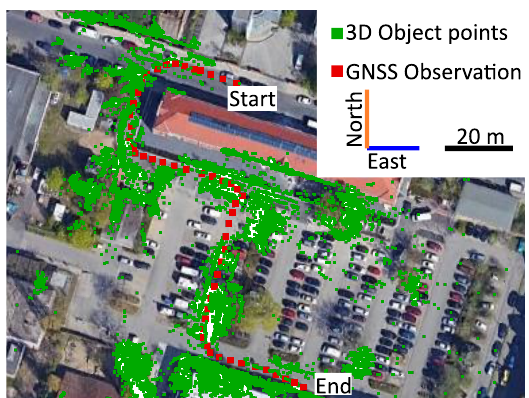
Figure 3. The trajectory driven by the two vehicles, represented by the GNSS observations and the 3D tie points. A satellite image of the area is used as background.